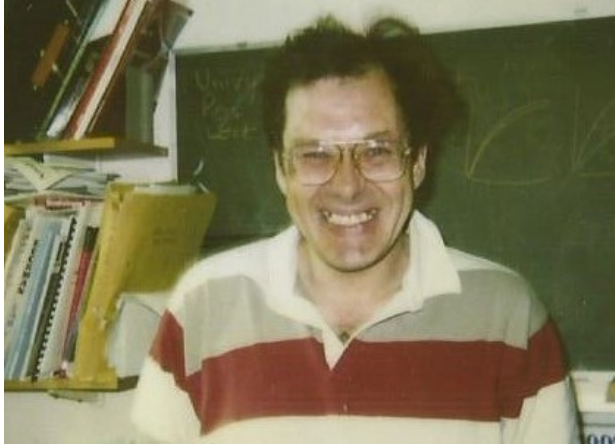
Figure 1. Dr. Robert Sim at work. This photograph was taken in 1992 in Bob’s office at the